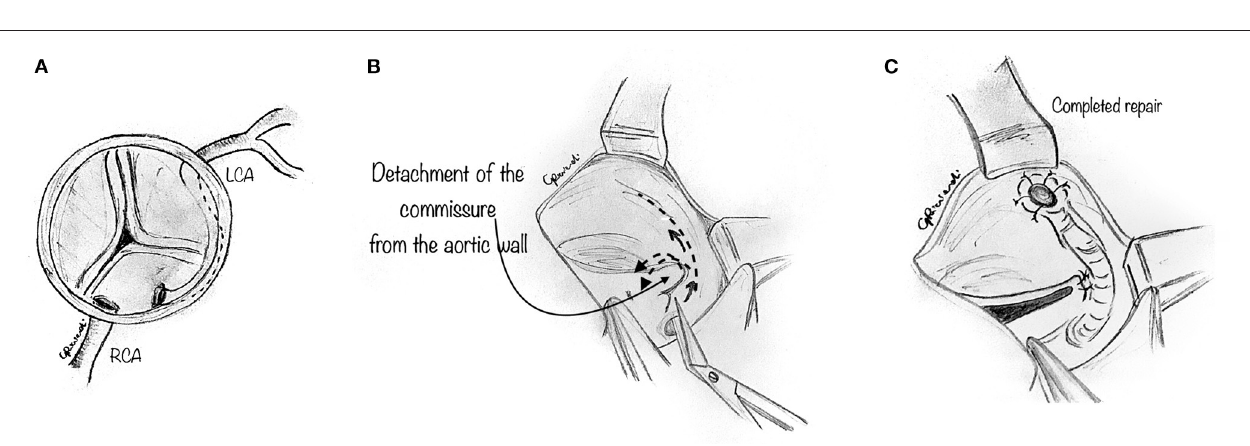
FIGURE 4 | Unroofing technique. The composite figures show a case of AAOLCA in which the intramural portion of the coronary goes from one aortic sinus into the next one by traversing the commissural plane (A) . The commissure is gently detached with a blade or fine scissor to expose the intramural portion of the coronary artery (B) . Then, the intramural portion of the anomalous coronary is unroofed, by cutting with fine scissors along its course until the take-off of the coronary from the aortic wall. Lastly, the entire intramural course is unroofed and the intima tacked around the new coronary ostium (C)